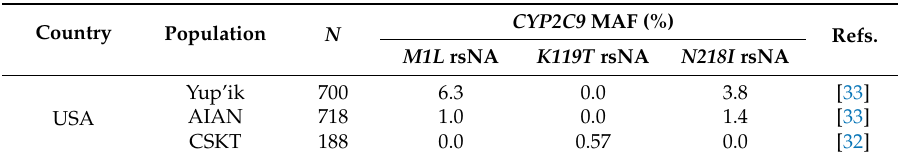
Table 7. Comparison of novel CYP2C9 allele frequencies identified by full gene resequencing in AN and AI populations, not found in other world